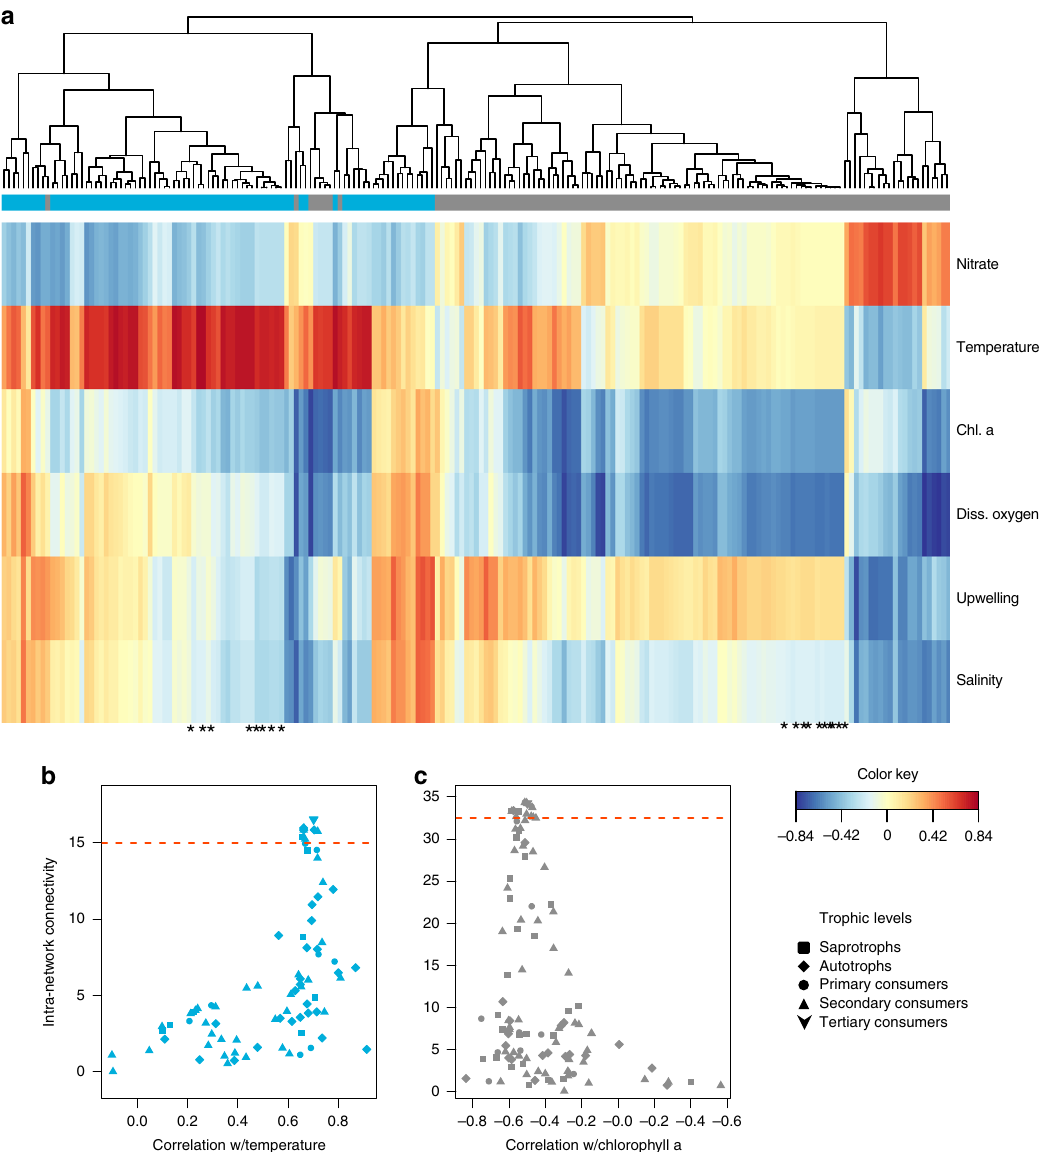
Fig. 3 Partial least square analysis between taxa and environmental variables, and plot of taxon connectedness and correlation to the environment. a Partial least square analysis plot showing the correlation of all taxa (columns), clustered by Kendall ’ s tau correlation coef fi cient, in the grey (winter)